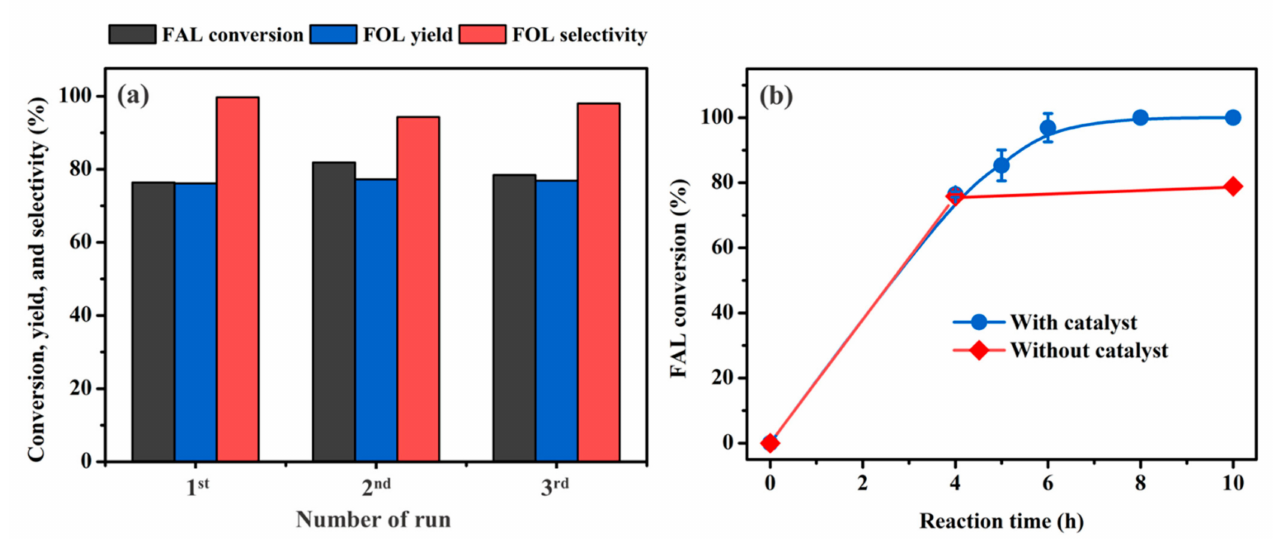
Figure 8. ( a ) Reusability of the Co 1.40 Cu 1 /CaO catalyst at a reaction temperature of 100 ◦ C, 20 bar H 2 pressure, and a reaction time of 4 h and ( b ) metal leaching investigation at a reaction temperature of 100 ◦ C and 20 bar H 2